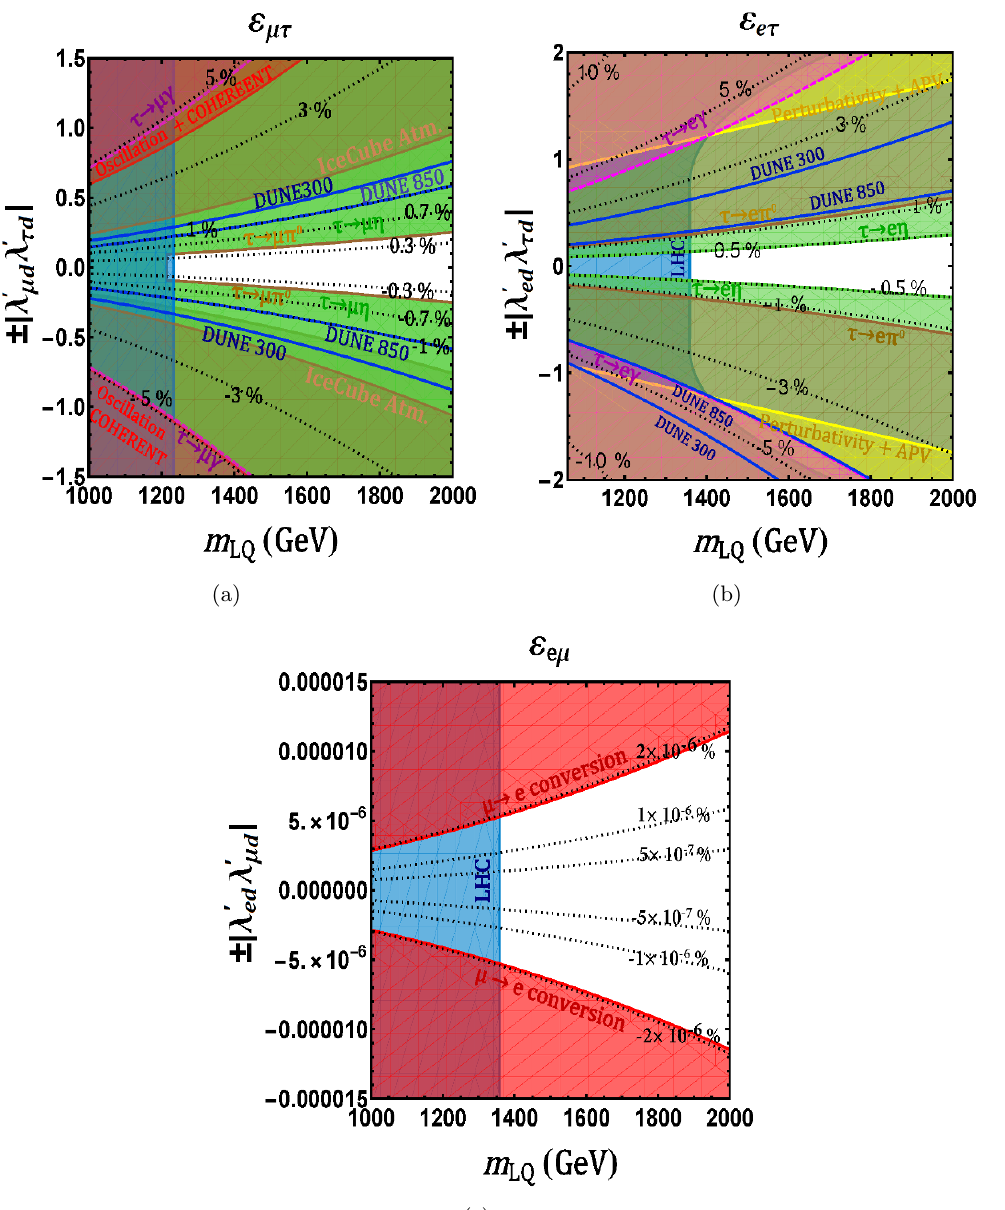
Figure 36 . Predictions for o(cid:11)-diagonal NSI ( " e(cid:22) ; " (cid:22)(cid:28) ; " e(cid:28) ) induced by the triplet LQ are shown by black dotted contours. Color-shaded regions are excluded by various theoretical and experimental constraints. The labels are same as in (cid:12)gure 32.